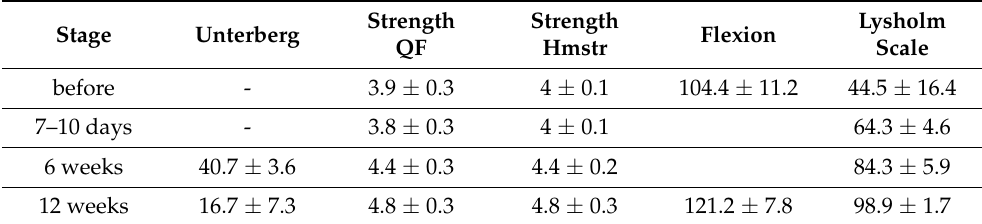
Table 3. Mean values with standard deviation for the Unterberg test, muscle strength test and Lysholm scale at individual stages of observation. QF—quadriceps muscle, Hmstr—muscle strength of the posterior